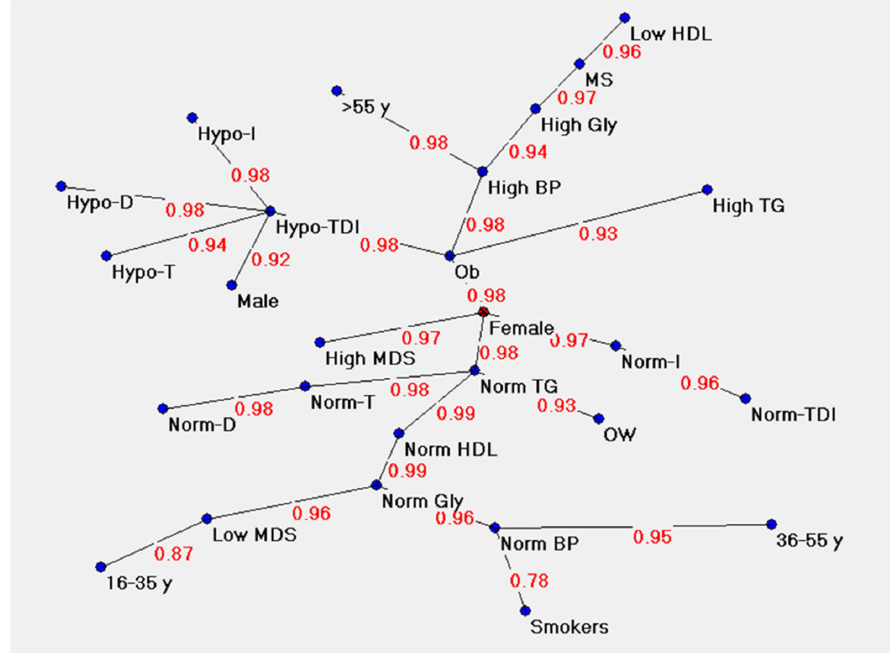
Figure 7. Map II shows the strength of the association among the variables considered. Hypo ‐ T, Hypo ‐ D, Hypo ‐ I, and Hypo ‐ TDI: subjects classified as hyposmic based on their score obtained with the Threshold (T), Discrimination (D), Identification (I) test, and their sum (TDI); Norm ‐ T, Norm ‐ D, Norm ‐ I, Norm ‐ TDI: subjects classified as normosmic based on their score obtained with the Threshold (T), Discrimination (D), Identification (I) test and their sum (TDI); OW: subjects with overweight; Ob: subjects with obesity; High BP: high blood pressure; Norm BP: normal blood pressure; High Gly: high glycemia; Norm Gly: normal glycemia; High TG: high triglycerides; Norm TG: normal triglycerides; Low HDL: High ‐ Density Lipoprotein; Norm HDL: High ‐ Density Lipoprotein; MS: subjects with metabolic syndrome; High MDS: high adherence to the Mediterranean diet (score ≥ 30); Low MDS: poor adherence to the Mediterranean diet (score < 30).